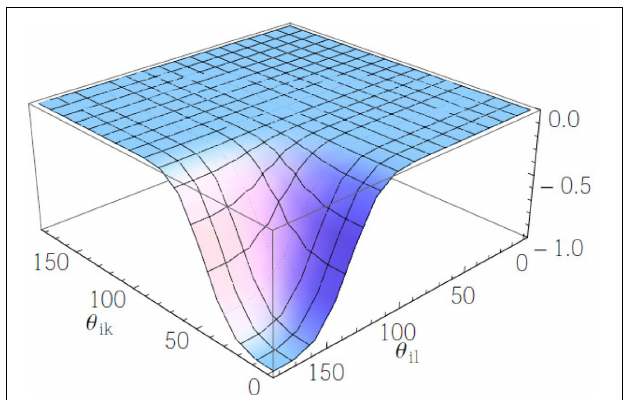
FIGURE 3 | The angular potential V ikl for σ θ = 0 . 28. θ ik and θ il are shown in degrees.